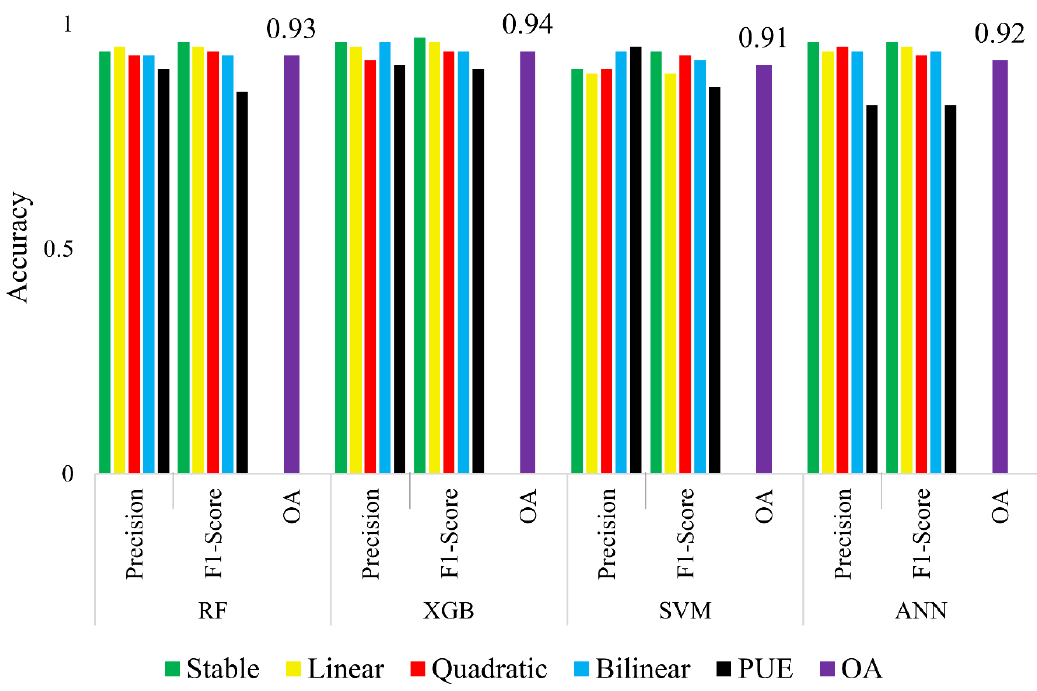
Figure 3. Precisions and F 1 -scores of the five deformation trends, along with the OAs of the proposed models using the GRN dataset.